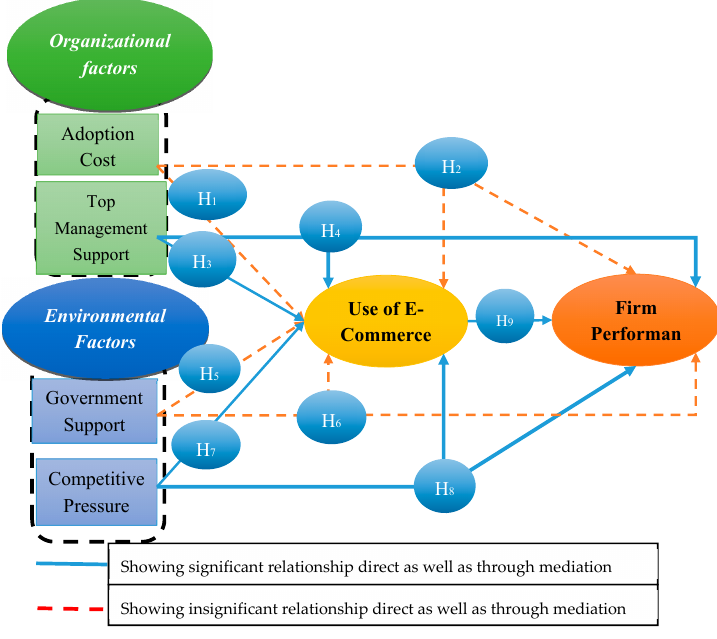
Figure 1. Theoretical framework. Source: authors